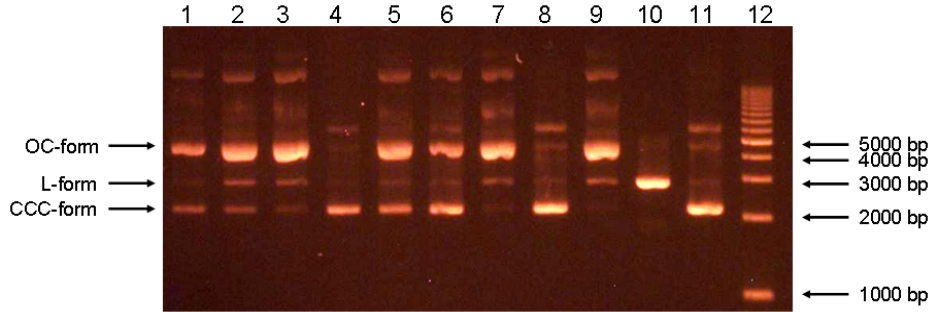
protect DNA in vitro . Lane 1-3: pUC19 + Fenton reaction + 1 (50:1, 10:1, 1:1); Lane 4: pUC19 + 1 50:1; Lane 5-7: pUC19 + Fenton reaction + rutin (50:1, 10:1, 1:1); Lane